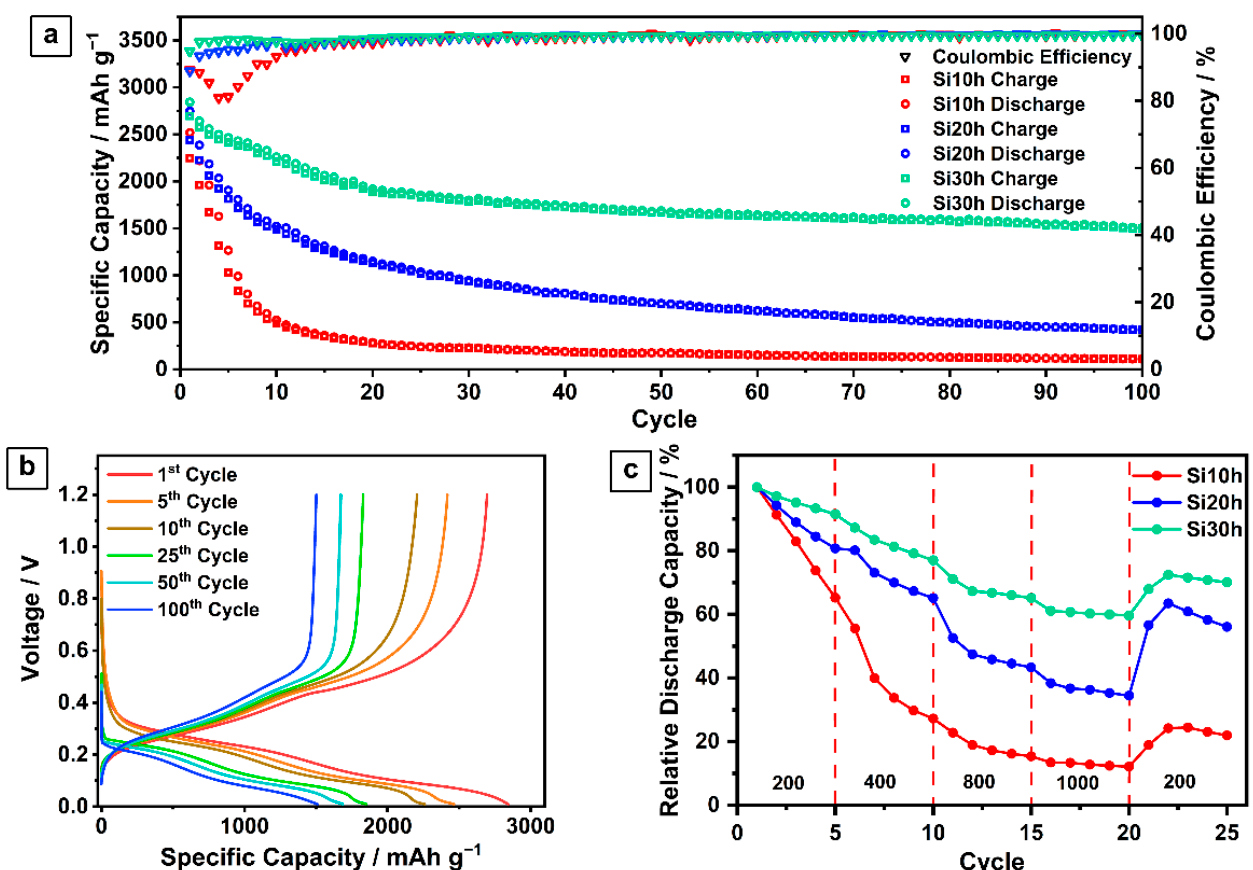
Figure 2. ( a ) Cycling stability curves of the cells with Si10h, Si20h, and Si30h electrodes at 400 mA g − 1 ; ( b ) Charge/discharge profiles of the cell with Si30h electrode; ( c ) Rate capability curves of the cells with Si10h, Si20h, and Si30h electrodes.